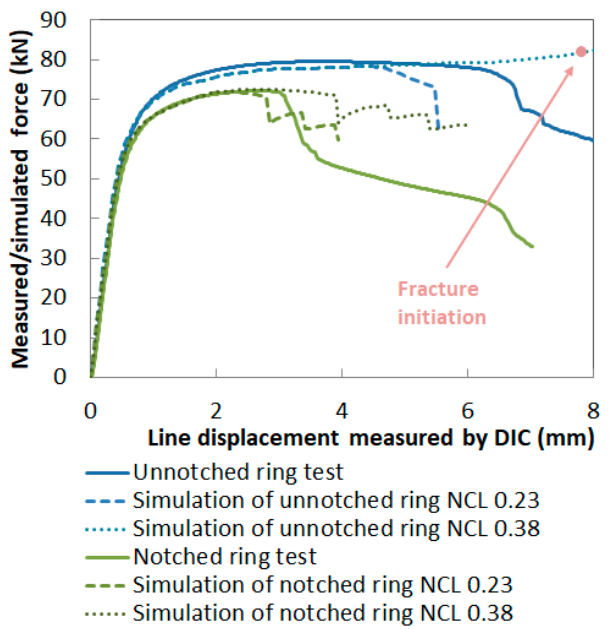
Figure 34. Measured forces in radial compression of rings and the forces simulated with the use of the Metals 2019 , 9 , x FOR PEER REVIEW 20 of 23